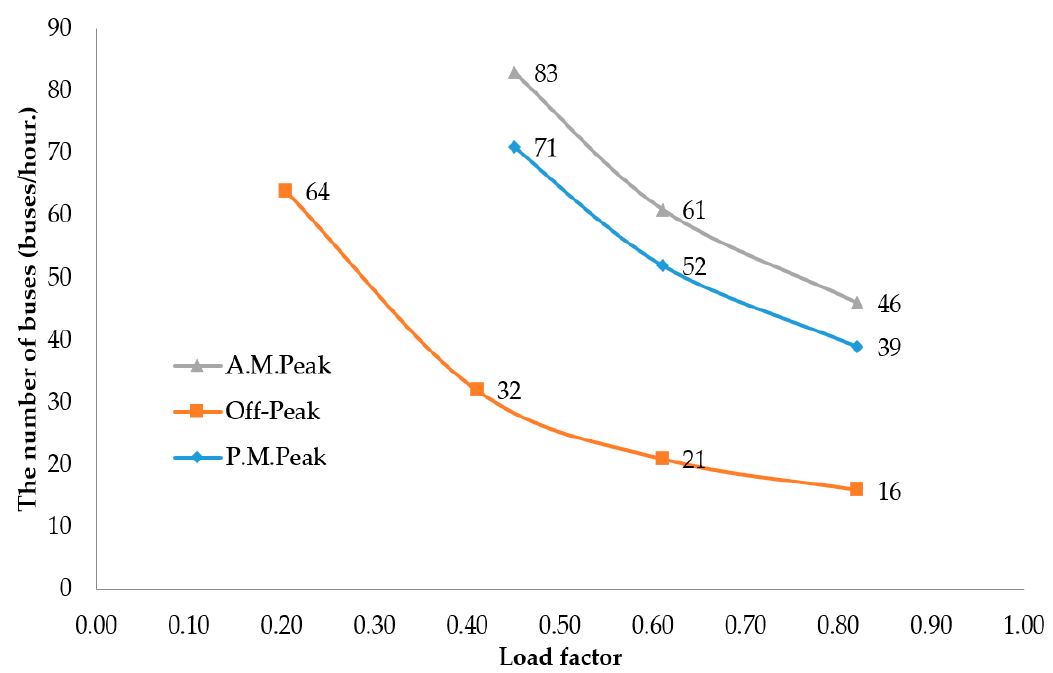
Figure 6. The Relationship between the Bus Frequency and Load Factor (LF) by Time Period for the Higher Demand Direction.